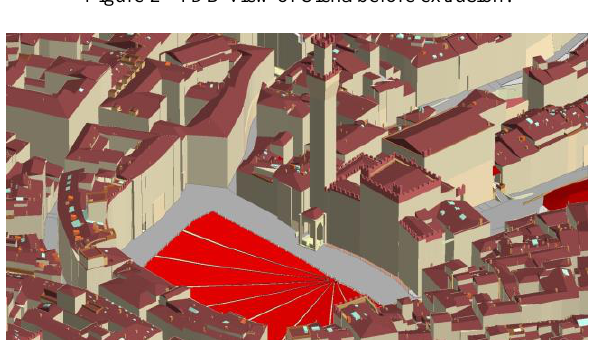
Figure 3 - TDB view of Siena after